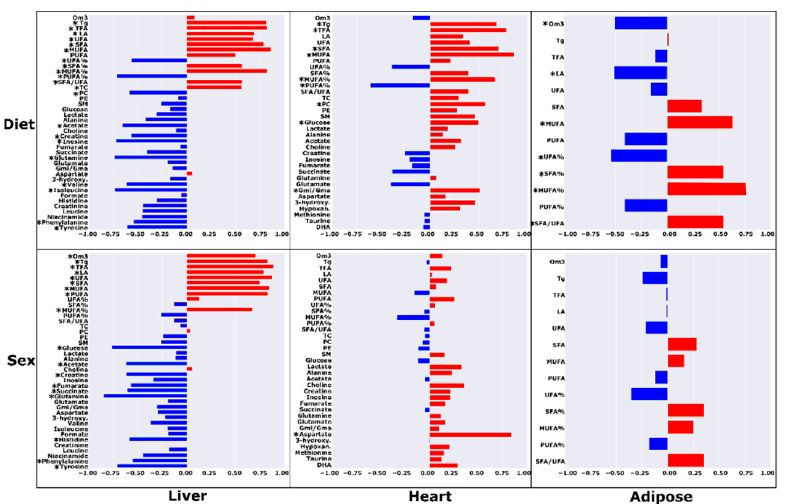
Figure 3. Correlations between metabolite levels with diet and sex in high-fat ad libitum (HF-AD) and chow-fed dietary groups for different tissues. For dietary partial correlations, metabolites with positive correlation coefficients are higher in HF-AD, and metabolites with negative coef- ficients are lower in HF-AD compared to chow. For sex partial correlations, metabolites with positive correlation coefficients are higher in females, and vice versa for negative coefficients com- pared to males. The metabolites with significant partial correlations ( p < 0.05) are denoted with asterisks (*). Abbreviations: Tg = triglycerides; PC = phosphatidylcholine; SM = sphingomyelin; PE = phosphatidylethanolamine; LA = linoleic acid; DHA = docosahexaenoic acid; MUFA = mo- nounsaturated fatty acids; PUFA = polyunsaturated fatty acids; UFA = unsaturated fatty acids; SFA = saturated fatty acids; Om3 = omega-3 fatty acids; TFA = total fatty acids; TC = total choles- terol; 3-hydroxy. = 3-hydroxybutyrate; Hypoxan. = hyphoxanthine; Gmi/Gma = ratio of glutamine to